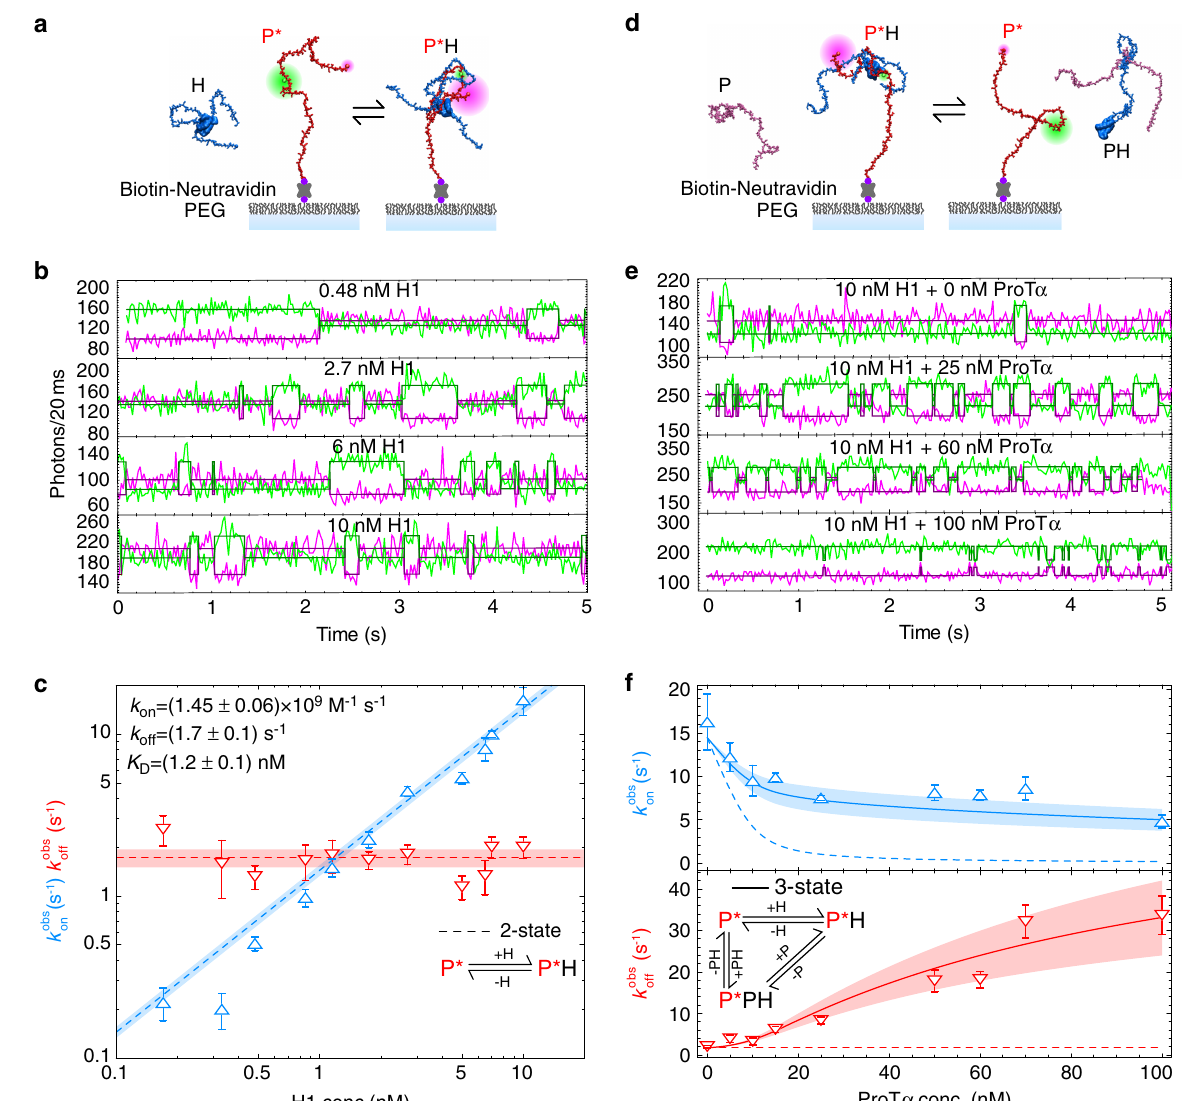
Fig. 3 Ternary complex formation explains binding kinetics. a Cartoon representation of surface-immobilized Avi-Tag-ProT α E56C/D110C labeled with Cy3B/LD650 (P*, red) binding to H1 (H, blue). b Representative single-molecule fl uorescence time traces in the presence of increasing concentrations of unlabeled H1 in solution (concentrations indicated in panels). The most likely state trajectories (bound/unbound) identi fi ed using the Viterbi algorithm are depicted as magenta and green lines. c Observed association ( k obs , blue upward triangles) and dissociation ( k obs , red downward triangles) rates as a on off function of the concentration of unlabeled H1. The fi t based on a two-state binding model (dashed lines) results in the rate coef fi cients k on = (1.45 ± 0.06)·10 9 M − 1 s − 1 and k off = (1.7 ± 0.1) s − 1 . d Cartoon representation of competition between surface-immobilized labeled ProT α bound to H1 with unlabeled ProT α (P, pink). e Experiment analogous to ( b ), but in the presence of 10 nM unlabeled H1 and different concentrations of unlabeled ProT α , as indicated in the panels. f k obs and k obs as a function of ProT α concentration with a fi t (solid lines) to a three-state model including the ternary complex PPH on off (see inset) and the dependencies expected for the two-state model shown in ( c ) (dashed lines) (see “ Methods ” for details). s.d. in ( c ) and ( f ) are from bootstrapping (see “ Methods ” for